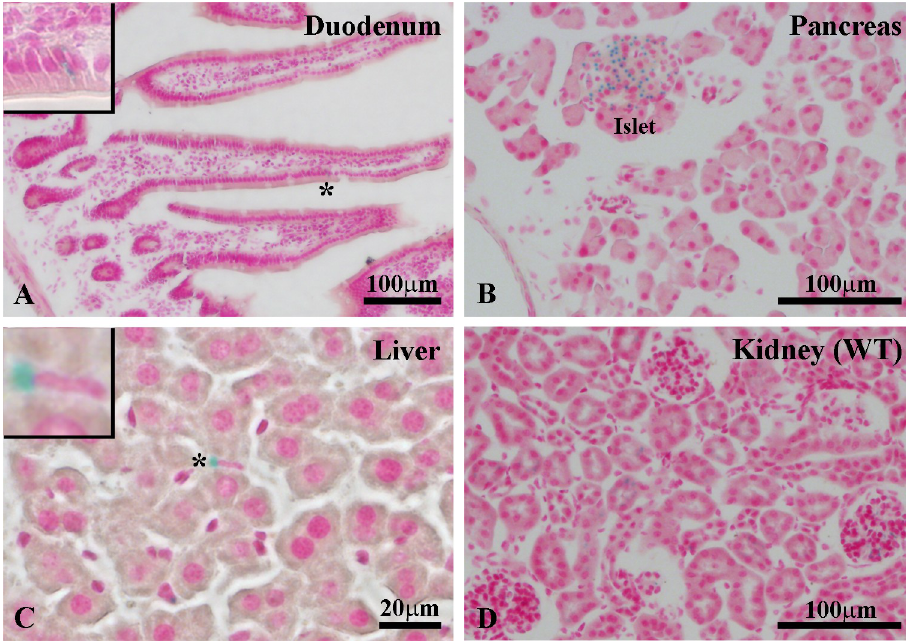
Fig 1. β -galactosidase reporter expression in tissues of Ildr1 -/- mice. β -galactosidase expression in (A) enteroendocrine cells of the duodenum, (B) pancreatic islets, and (C) Kupffer cells of the liver. Inset in panels A and C from areas marked with an asterisk in the respective panels. (D) No X-gal staining was detected in wild-type mouse kidney (control). Scale of each image is provided in the panel.